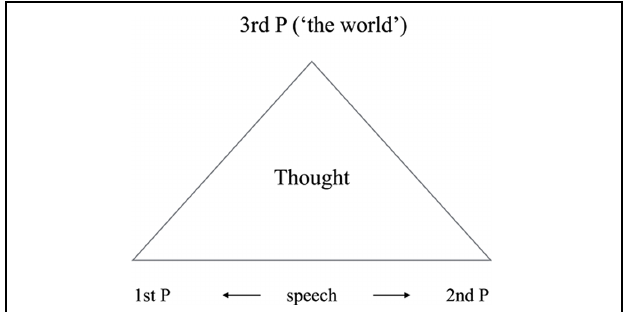
FIGURE 1 | The deictic frame of speech and thought. A grammatical 1st Person, addressing a 2nd, talks about an object or event in the world (the ‘it’ or 3rd Person) expressing a thought.